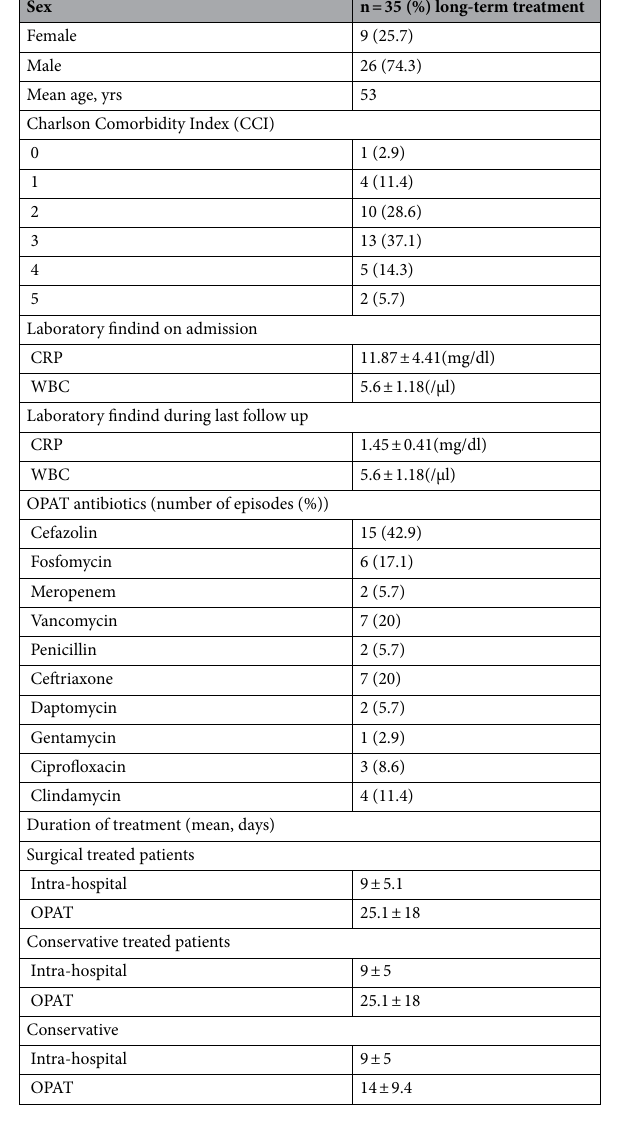
Table 1. Characteristics of outpatient parenteral antibiotic therapy for patients with long-term